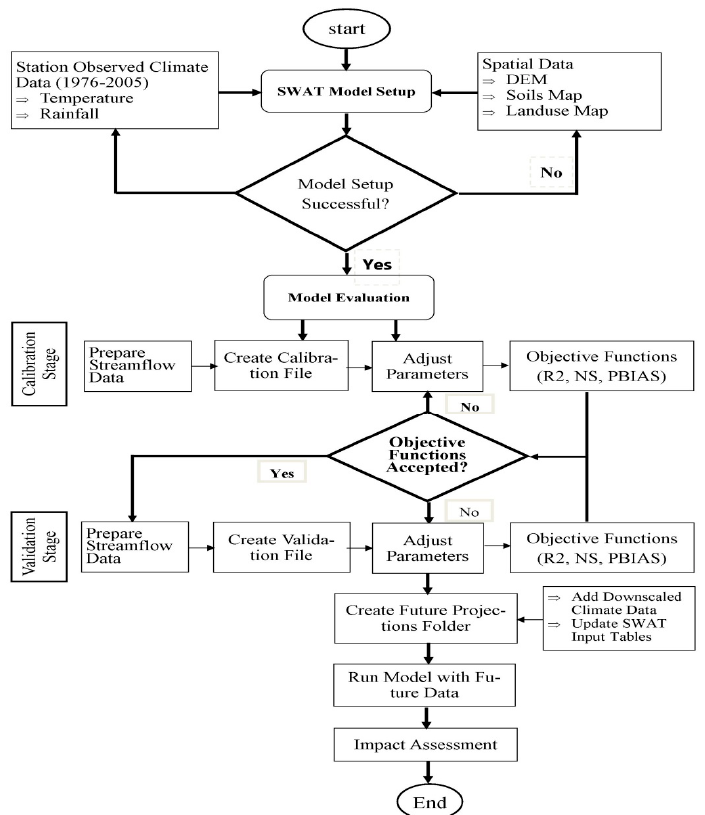
Figure 2. Framework of the study for the assessment of climate change impacts on future flows of the Bernam River Basin. NS, Nash–Sutcliffe ; PBIAS, Percent Bias.